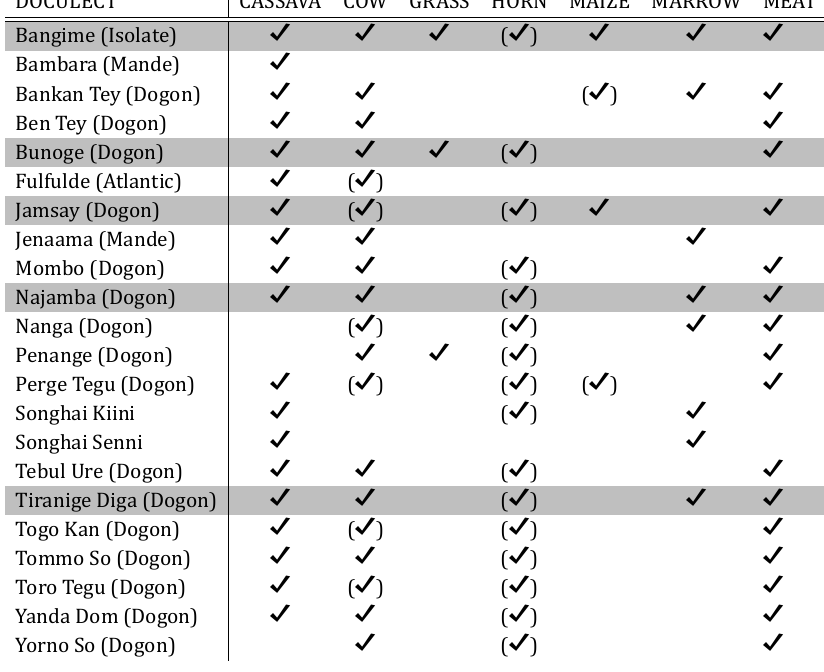
Table 8: Shared agricultural vocabulary